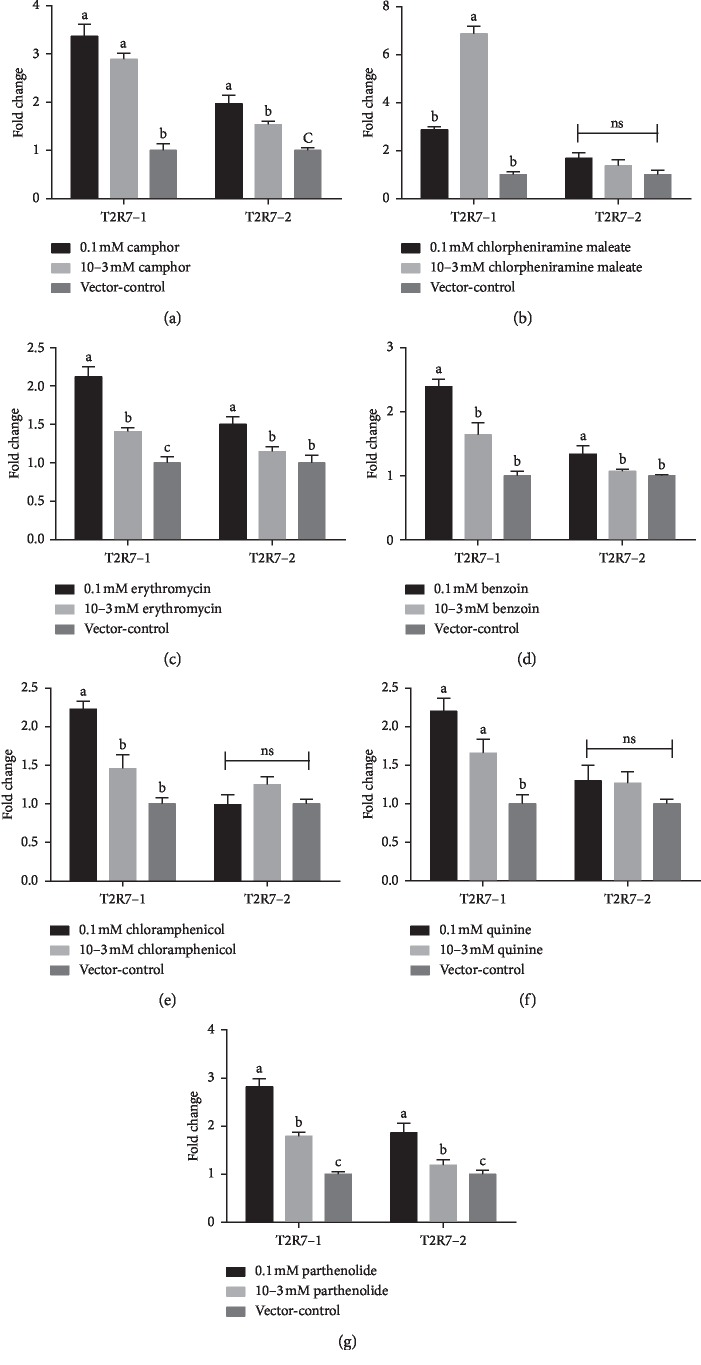
Relative expression levels of ITPR3 mRNA in cT2R7-1/pDisplay-Gα16/gust44/pcDNA3.1 (+) and cT2R7-2/pDisplay-Gα16/gust44/pcDNA3.1 (+) cells stimulated by different concentrations of (a) camphor, (b) chlorpheniramine maleate, (c) erythromycin, (d) benzoin, (e) chloramphenicol, (f) quinine, and (g) parthenolide, as determined by real-time PCR. The relative gene expression was measured by qPCR and normalized to GAPDH, and the vector-control was the negative control. Each bar represents the mean ± SE of the results from 2 to 3 independent experiments performed in triplicate. Different small letters on the bar indicate significant differences at P < 0.05.